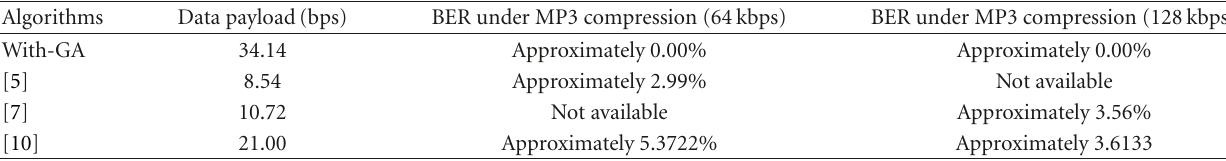
Table 6: Algorithm comparison.